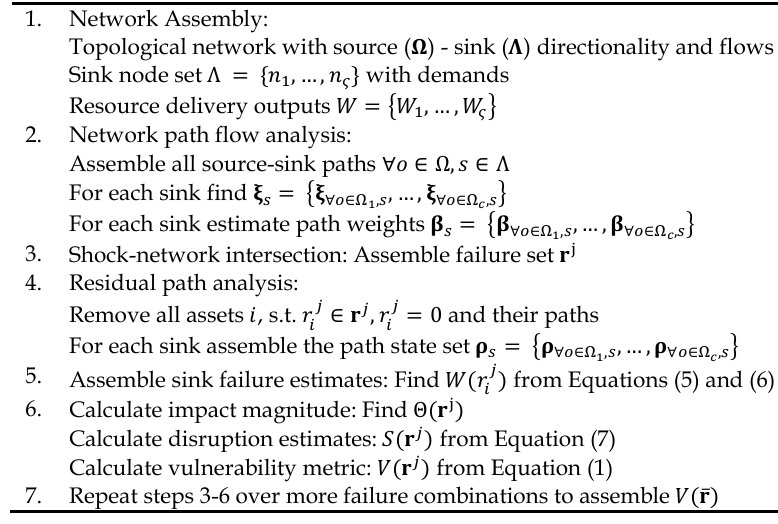
Algorithm to simulate the network failures and vulnerability calculations. Table